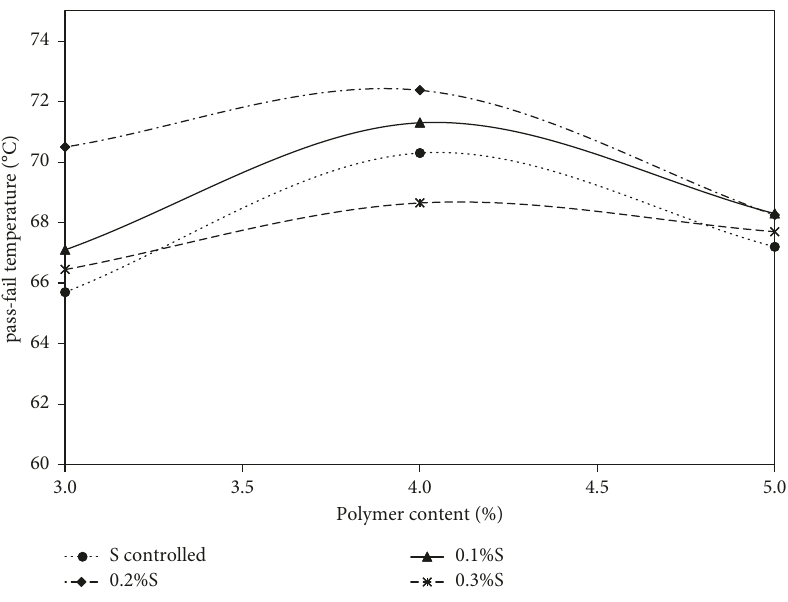
Figure 6: Pass-fail temperature of modified bitumen. Table 3: High temperature performance grades of base and modified